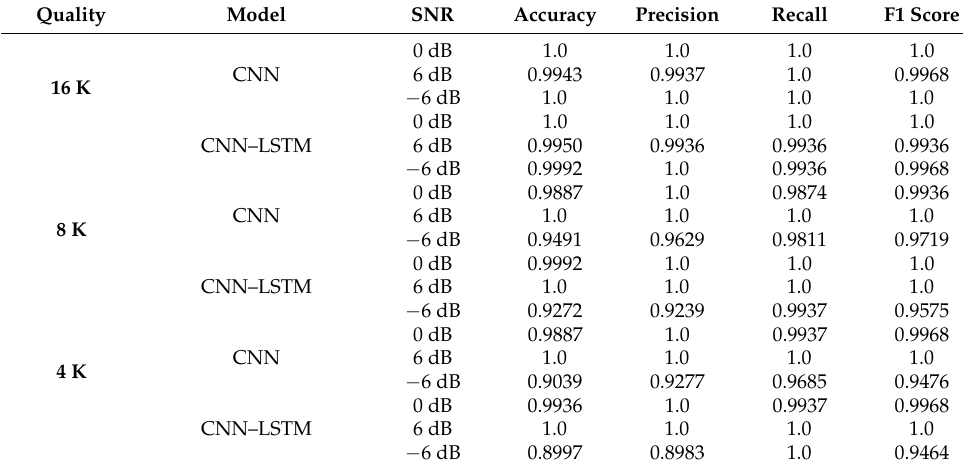
Table 2. Result of training on the CNN and CNN–LSTM models by performing Hilbert transform for valve data.